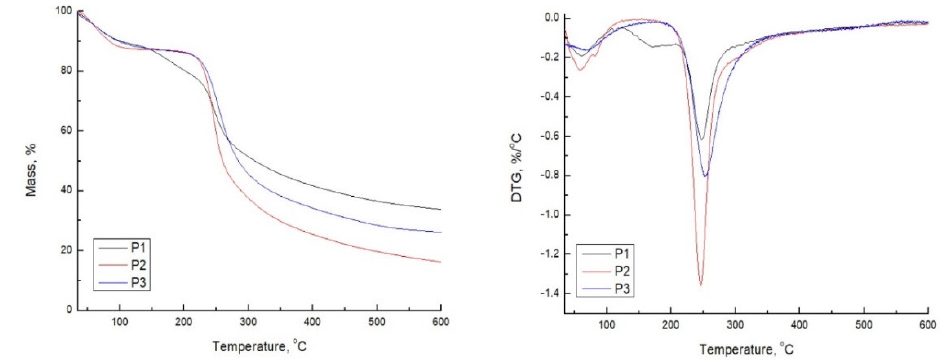
Table 3. Thermal properties of pectin monolith cryogels, where W L100 and W L180 present the weight loss at 100 °C and 200 °C, respectively, Tonset is the temperature at which starts degradation, and Tdeg is the temperature of maximum degradation rate.